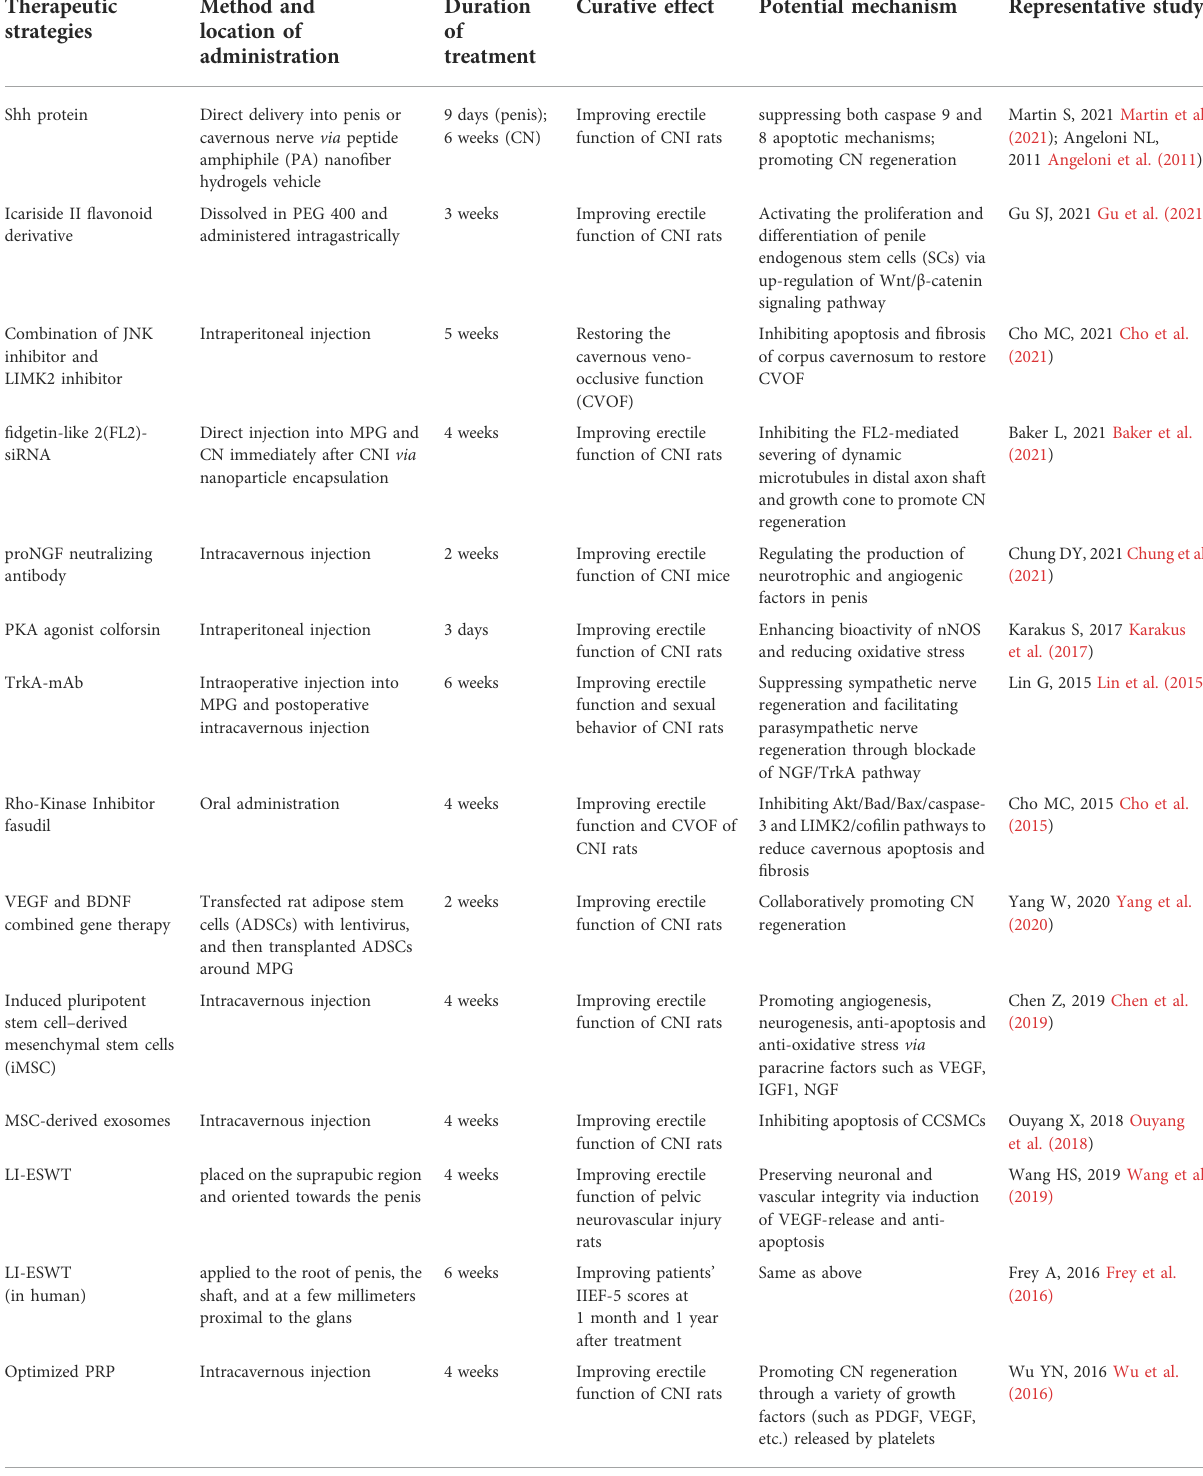
TABLE 1 Novel therapeutic strategies of CNI-Related